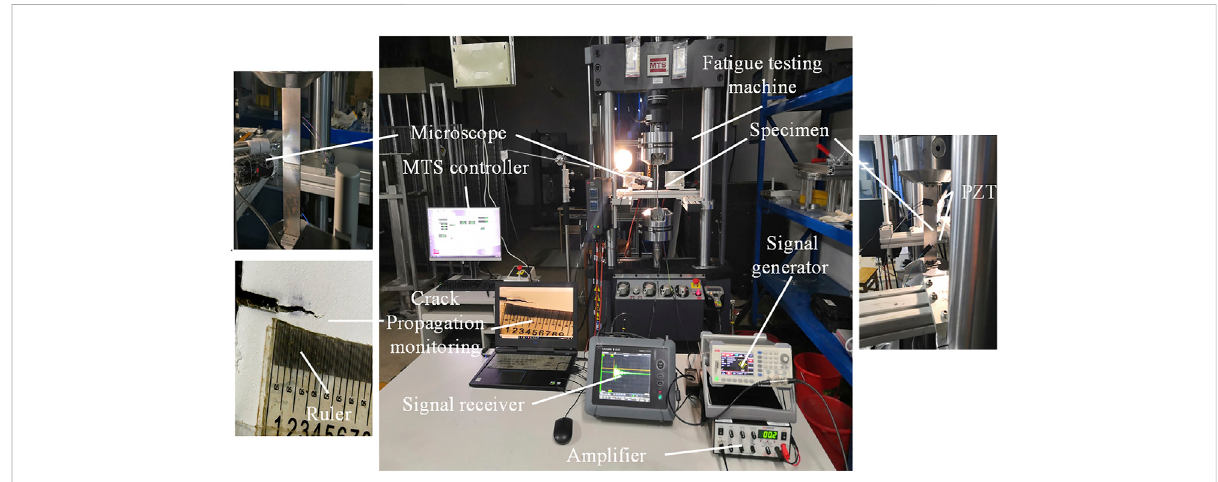
FIGURE 4 The experimental platform for fatigue crack growth monitoring.